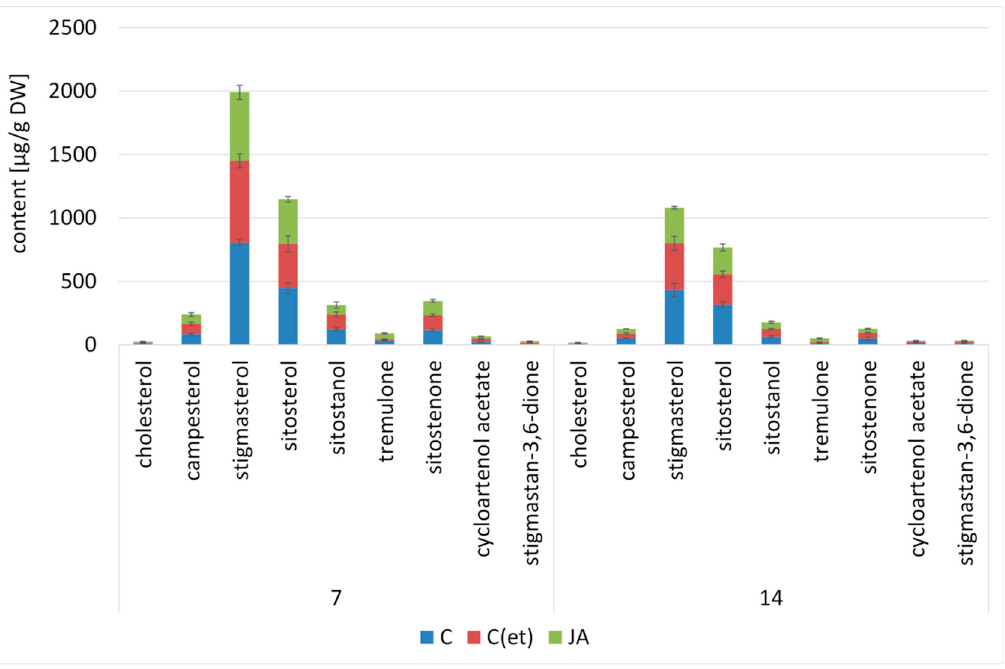
Figure 11. The content of free sterols in C. officinalis roots. C—control, C(et)—control samples treated with the adequate volume of 70% ethanol, JA—jasmonic acid-elicited samples. See detailed data and statistical significance in Table S15.